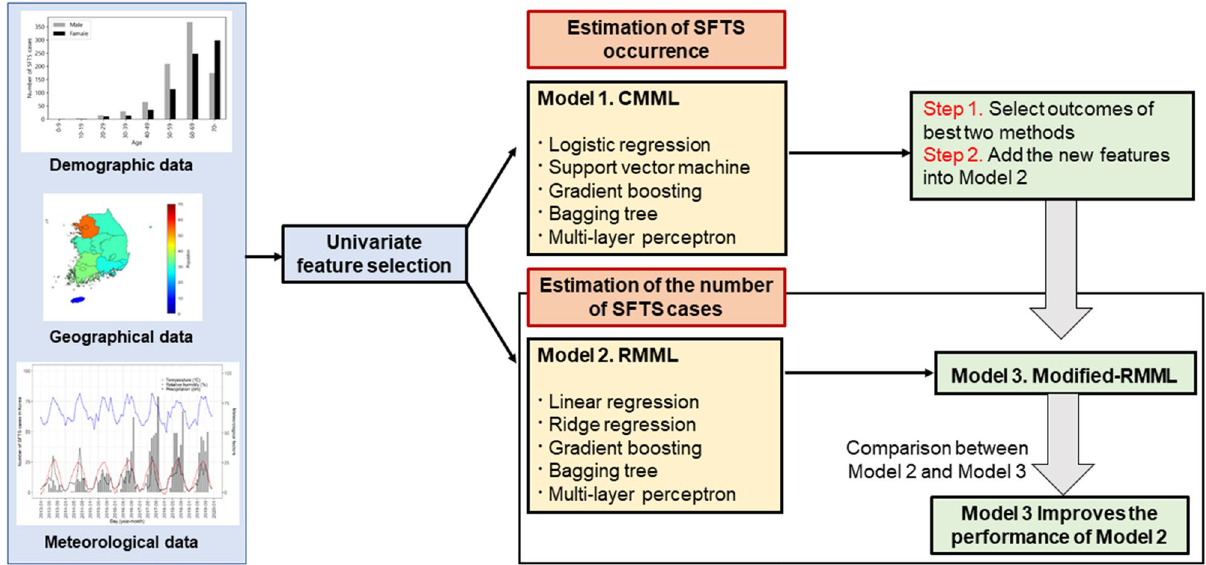
Figure 6. Schematic diagram predicting monthly occurrence and number of severe fever with thrombocytopenia syndrome